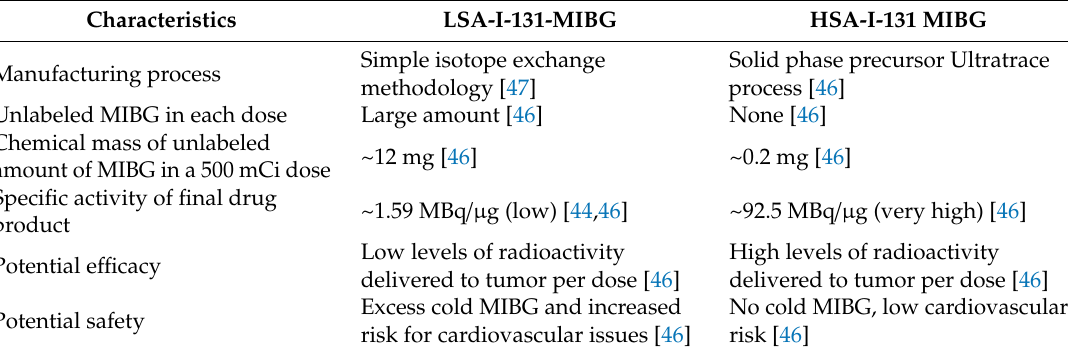
Table 1. Di ff erences between LSA- and